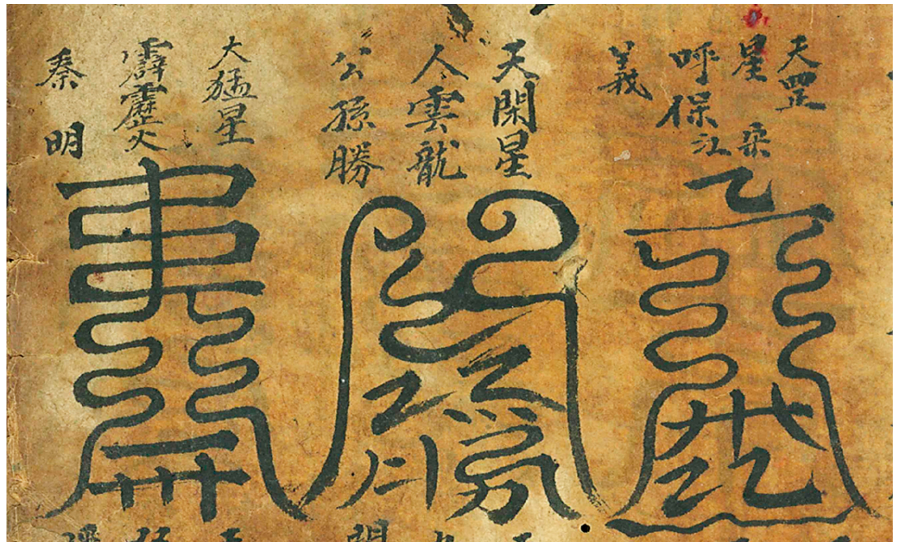
Figure 4. The first three writs of the Li County manual. From right to left: Song Jiang, Gongsun Sheng and Qin Ming.